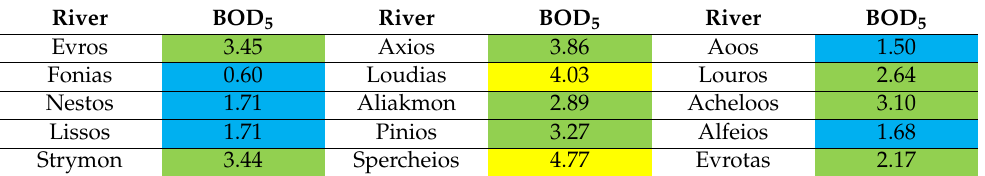
Table 5. Average BOD 5 concertation in the examined rivers (mg O 2 /L) according to data of the NMP (2012–2015, 2018–2019). Colors present quality classes; high < 2, good 2 to <4, moderate 4 to < 7 (strictest prescriptions depicted by the authors of [52]). River BOD 5 River BOD 5 River